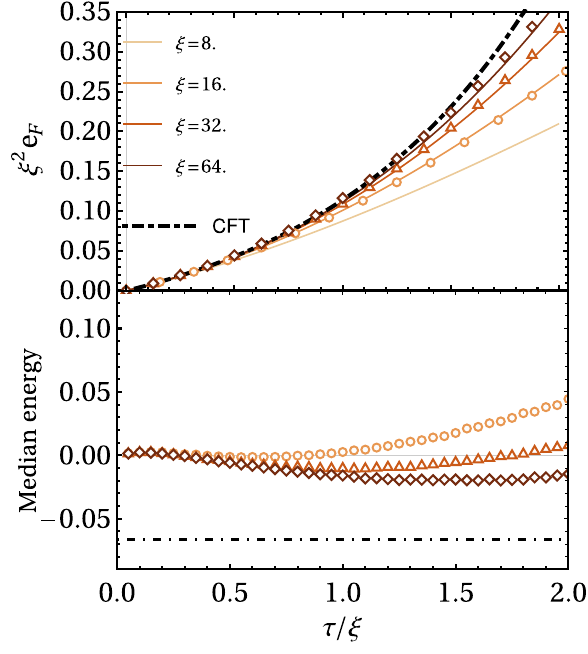
τ Þ vs t ¼ τ = ξ , the scaled samples.FIG. 2. Top: the average energy e F ð time, for different values of the noise correlation length ξ . Continuous lines are obtained from the numerical solution of the Wigner function equation (47), while the markers correspond to the exact dynamics of Eq. (44) for L ¼ 2048 . The dot-dashed line is the CFT result (40), which from Eq. (49) is predicted to hold for large ξ . Bottom: the median of the distribution of ξ 2 ðh ˆ h − h ˆ h vs the scaled time τ = ξ . In the limit of ξ → ∞ , i i τ i i 0 Þ the median is expected to decrease toward the negative asymp- totic value predicted by CFT (dot-dashed horizontal line). For finite ξ , the median starts to grow at large times, suggesting that heating may eventually dominate on the